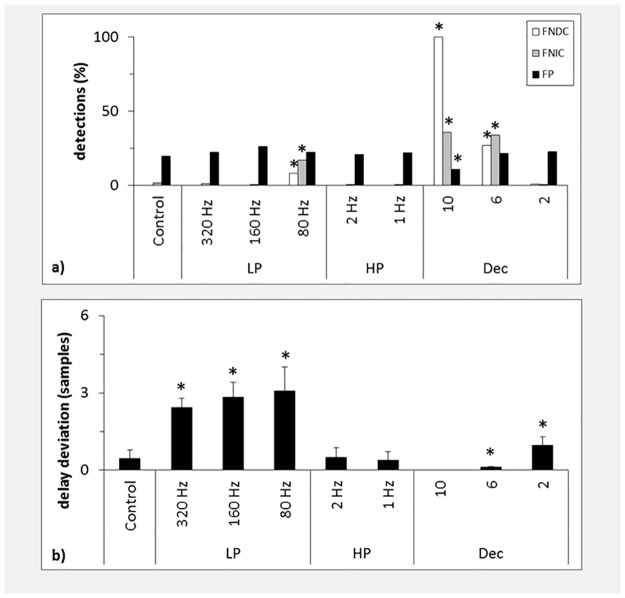
Results for the CSEM.a) False detections in percent for the CSEM. b) Delay deviations for the CSEM. LP: low-pass filter, HP: high-pass filter, Dec: decimation. Asterisks indicate results significantly different from control (a: Fisher’s exact test, p < = 0.05, Bonferroni corrected, b: Wilcoxon rank-sum test, p < = 0.05). Error bars indicate standard deviation.